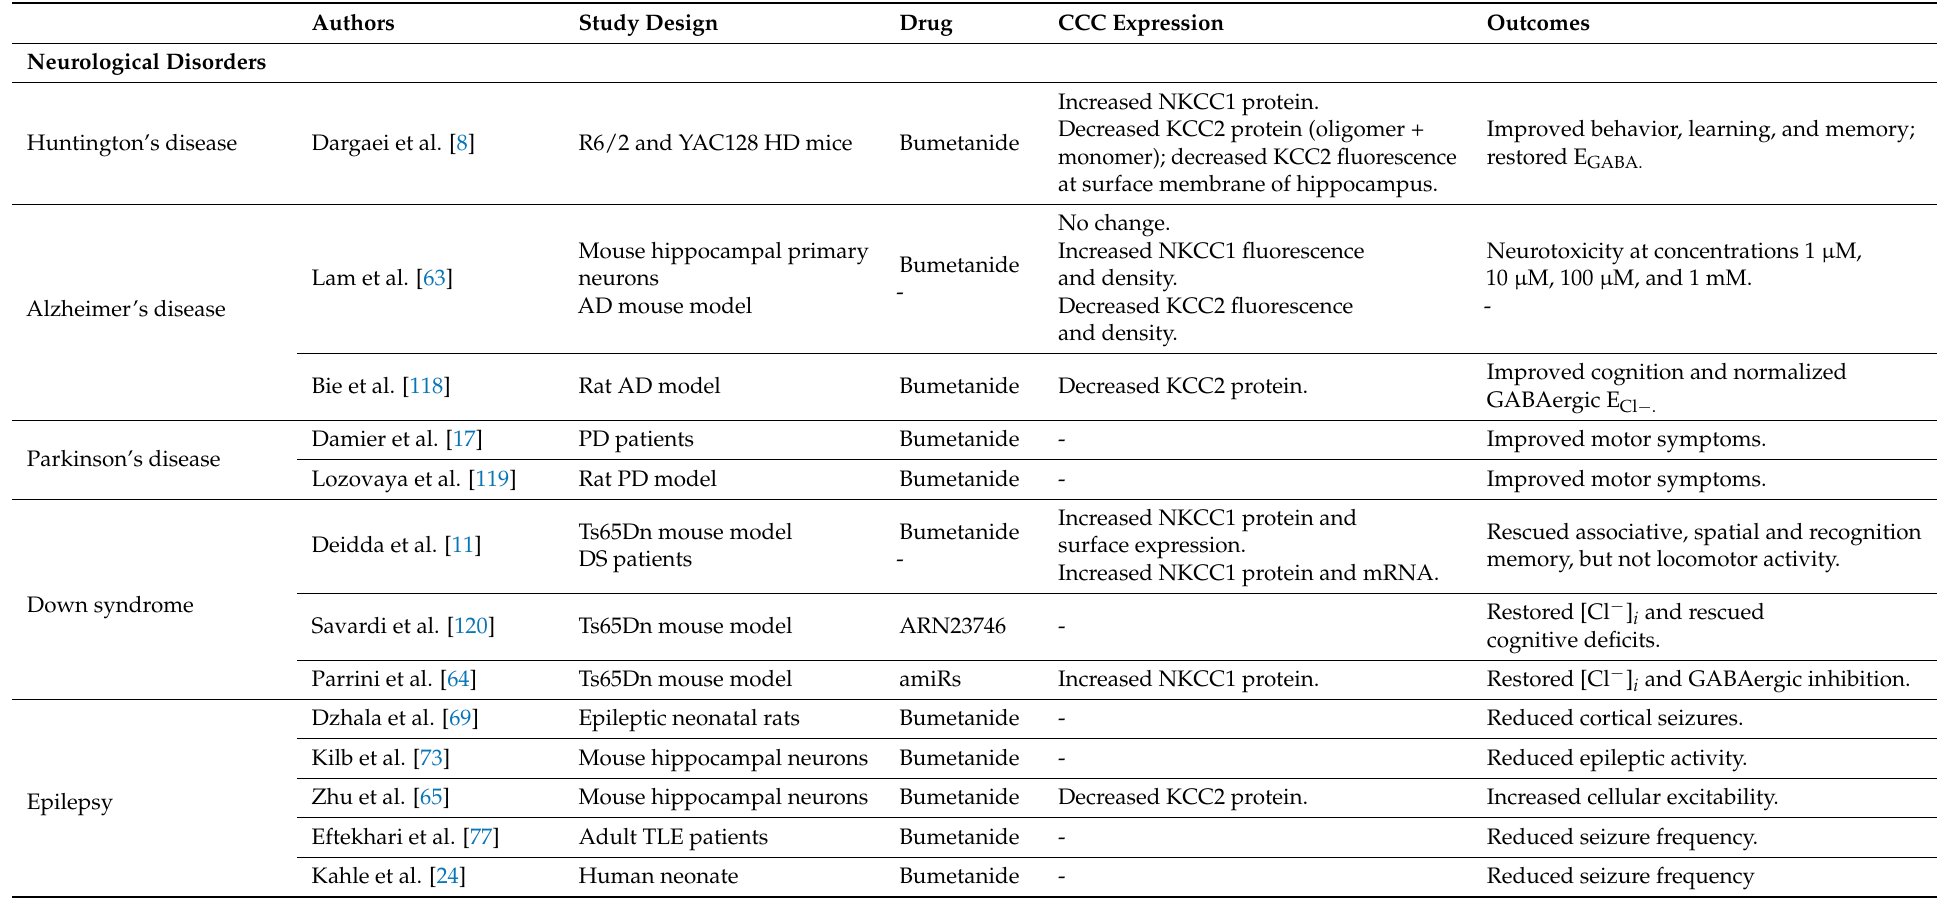
Table 1. Summary of CCC alterations in neurological and neuropsychiatric disorders, and the therapeutic effect of bumetanide and other CCC targeting therapies